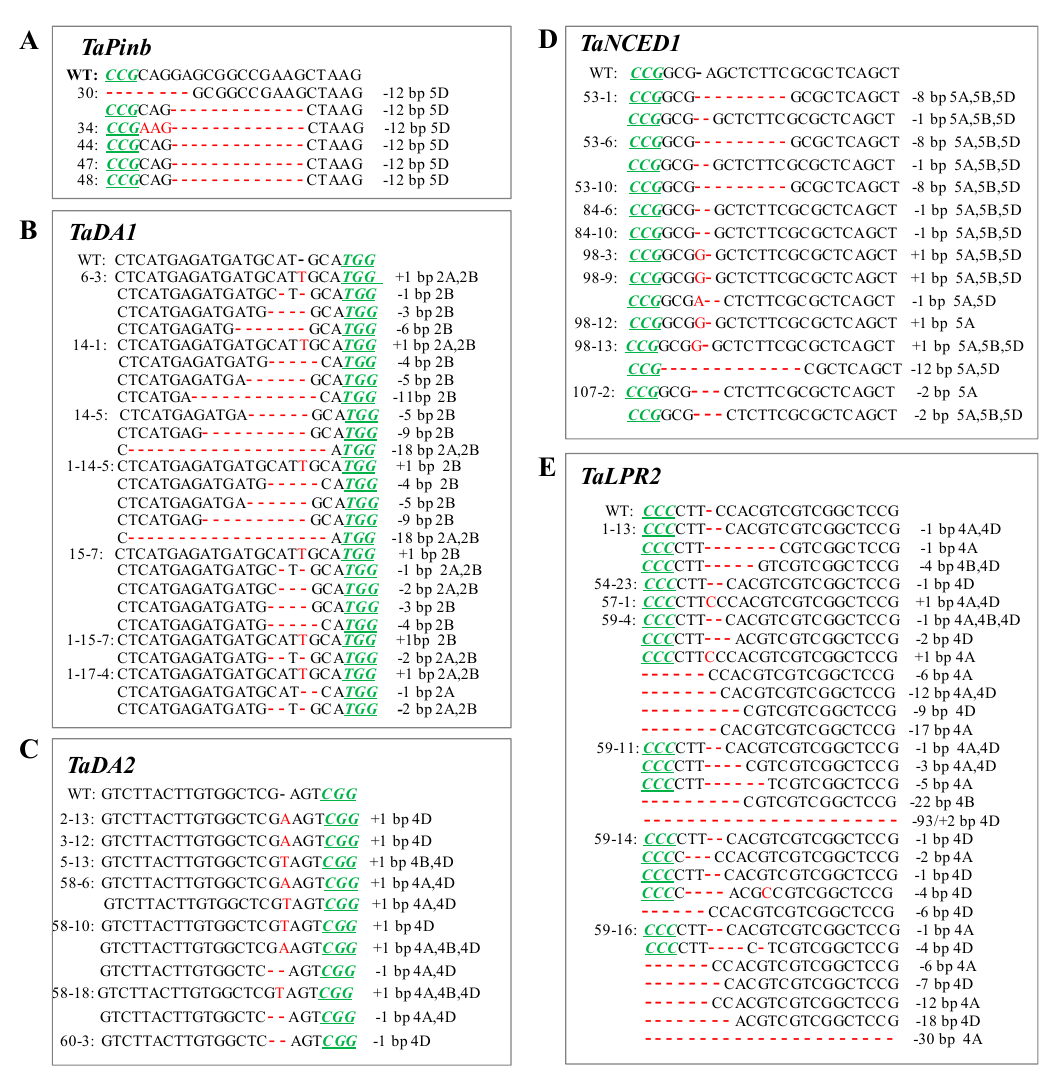
Figure 4. CRISPR / Cas9-induced targeted mutagenesis of the target genes TaPinb ( A ), TaDA1 ( B ), TaDA2 ( C ), TaNCED1 ( D ) and TaLPR2 ( E ) in T2 plants. The mutation sites are indicated by red. The PAM (NGG) sites are underlined and indicated in italics in green.